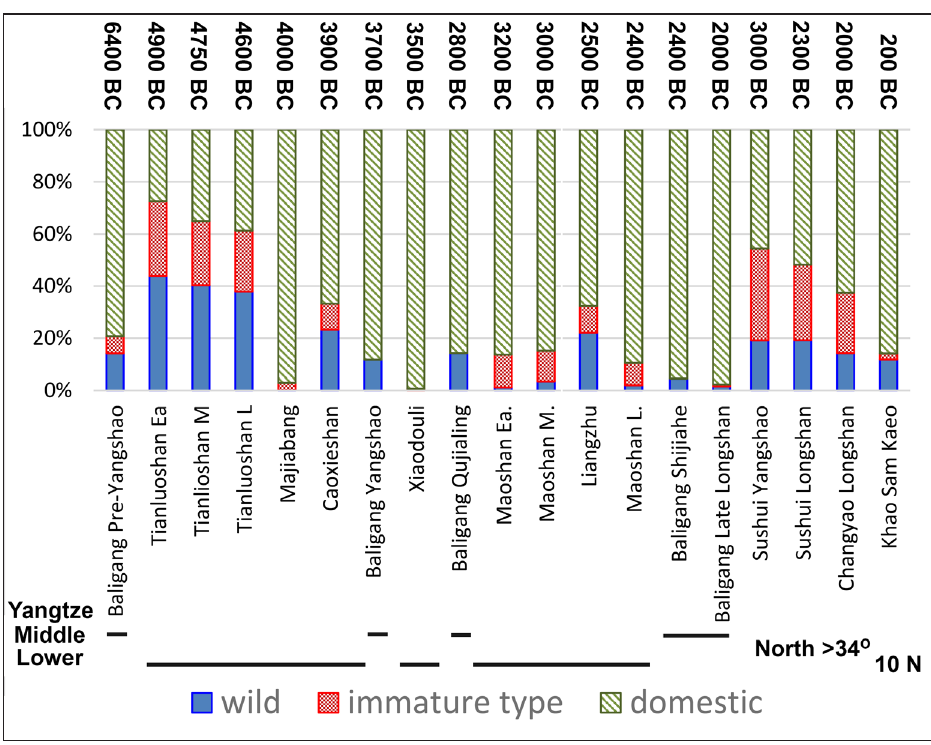
Figure 3: A comparison of the proportions of rice types for various sites and phases in China and Iron Age Thailand, as classified by spikelet bases, separating shattering (wild or weedy), non-shattering (domesticated) and green-harvested (immature). This chart summarizes data on 35,309 identified archaeological spikelet bases studied since 2006 (Chart prepared by